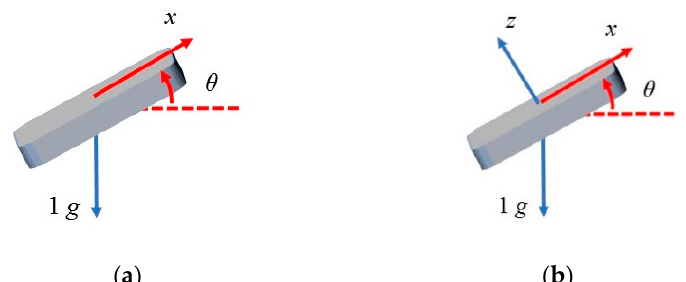
( d ) Figure 1. Sensing angles of the MEMS inclinometer. ( a ) The typical reference position; ( b ) an illustration of angles 𝜙 and 𝜃 and the relationship between them; ( c ) an illustration of angles 𝜓 and 𝜙 and the relationship between them; ( d ) three sensing angles of the MEMS inclinometer. The equations above are derived based on 3-axis accelerometers, which have been widely used. However, they are also suitable for 1-axis and 2-axis accelerometers. Figure 2a illustrates the angular measurement of the 1-axis MEMS accelerometer, which is similar to the angular measurement of the angle θ of the 3-axis MEMS accelerometer, as seen in Figure 1b. The difference between the 1-axis MEMS accelerometer and the 3-axis MEMS accelerometer is that the former cannot read the data of the y-axis and z-axis. Therefore, for the 1-axis MEMS accelerometers, assuming